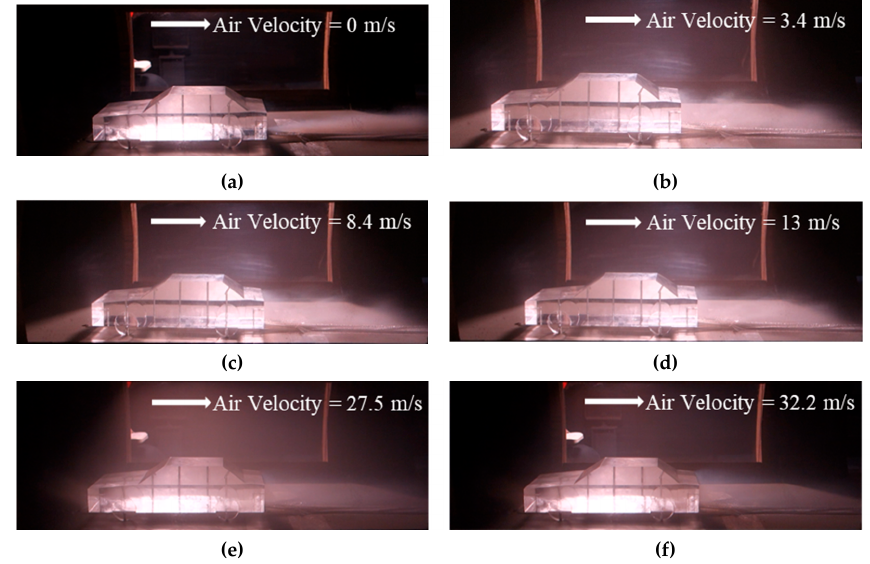
Figure 4. Typical flow patterns, (a) Flow Pattern 1; (b) Flow Pattern 2; (c) Flow Pattern 3; (d) Flow Pattern 4; (e) Flow Pattern 5; (f) Flow Pattern 6.